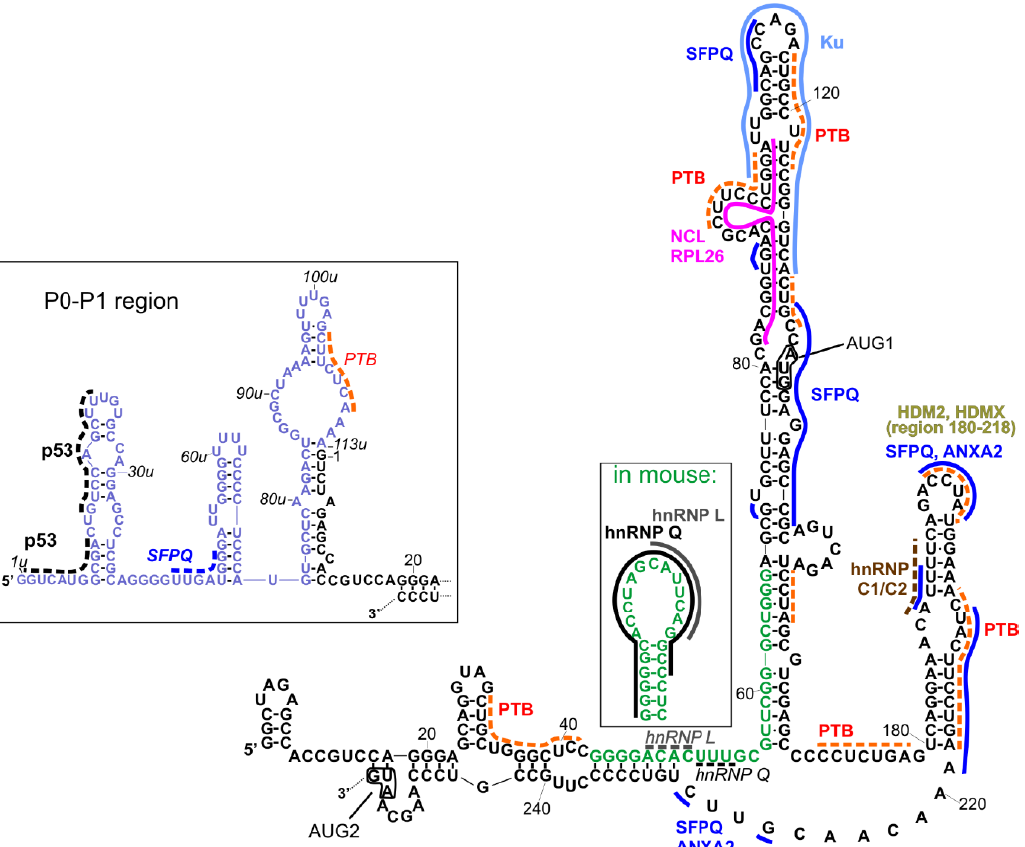
Figure 2. Interactions with proteins that were indicated for variants of 5 ′ UTR of p53 mRNA. Black fonts represent the RNA sequence of human 5 ′ UTR of P1- Δ40p53 mRNA. Blue fonts indicate the region between P0 and P1 transcription start sites present at the 5 ′ end of P0-p53 mRNA. Green fonts show a differently folded fragment of analogous sequence present in mouse p53-mRNA. Names of proteins, written in bold, pertain to the established interactions with one of 5 ′ UTR-p53 variants. The particular site of such interactions is indicated by solid line in the same color as the name of the protein. In the event that the particular site of the interaction is not confirmed but only predicted, the line is dotted. Italics depict interactions which were not indicated for human mRNA variant and are proposed in analogy to mouse. For some proteins, only wider regions of interactions were investigated, and there are no lines indicating their interaction sites. Translation start sites are depicted in boxes and named AUG1 and AUG2. Detailed description is provided in the text.